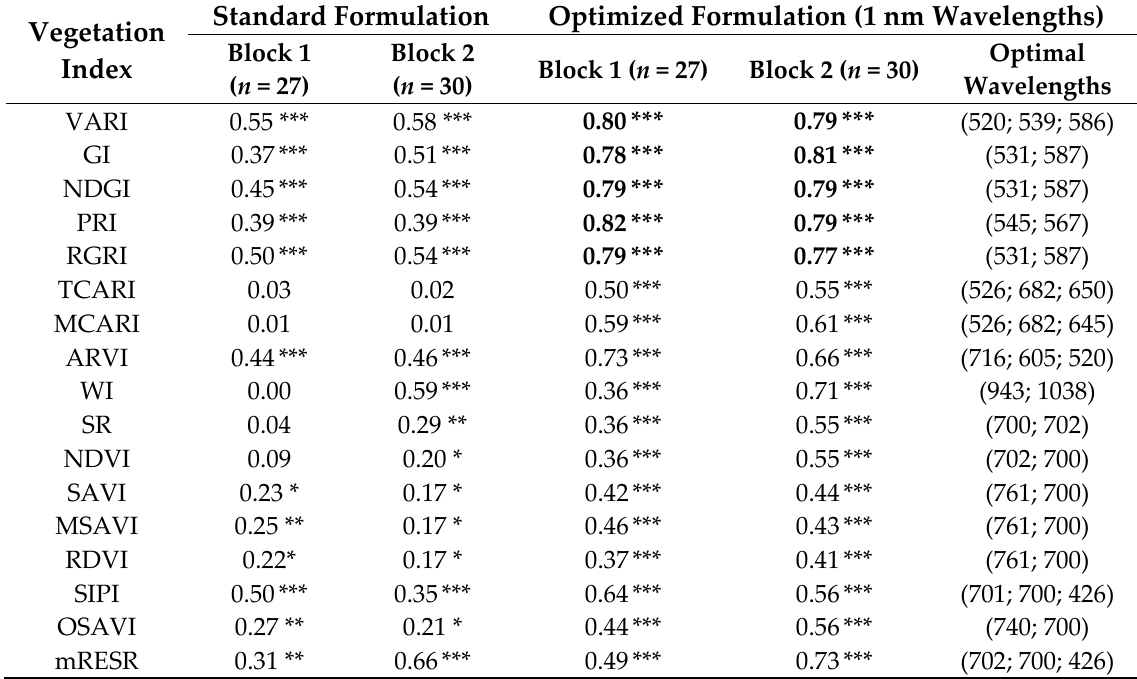
Significance level: * p < 0.05; ** p < 0.01; *** p < 0.001. The formulation of the VI is presented in Table